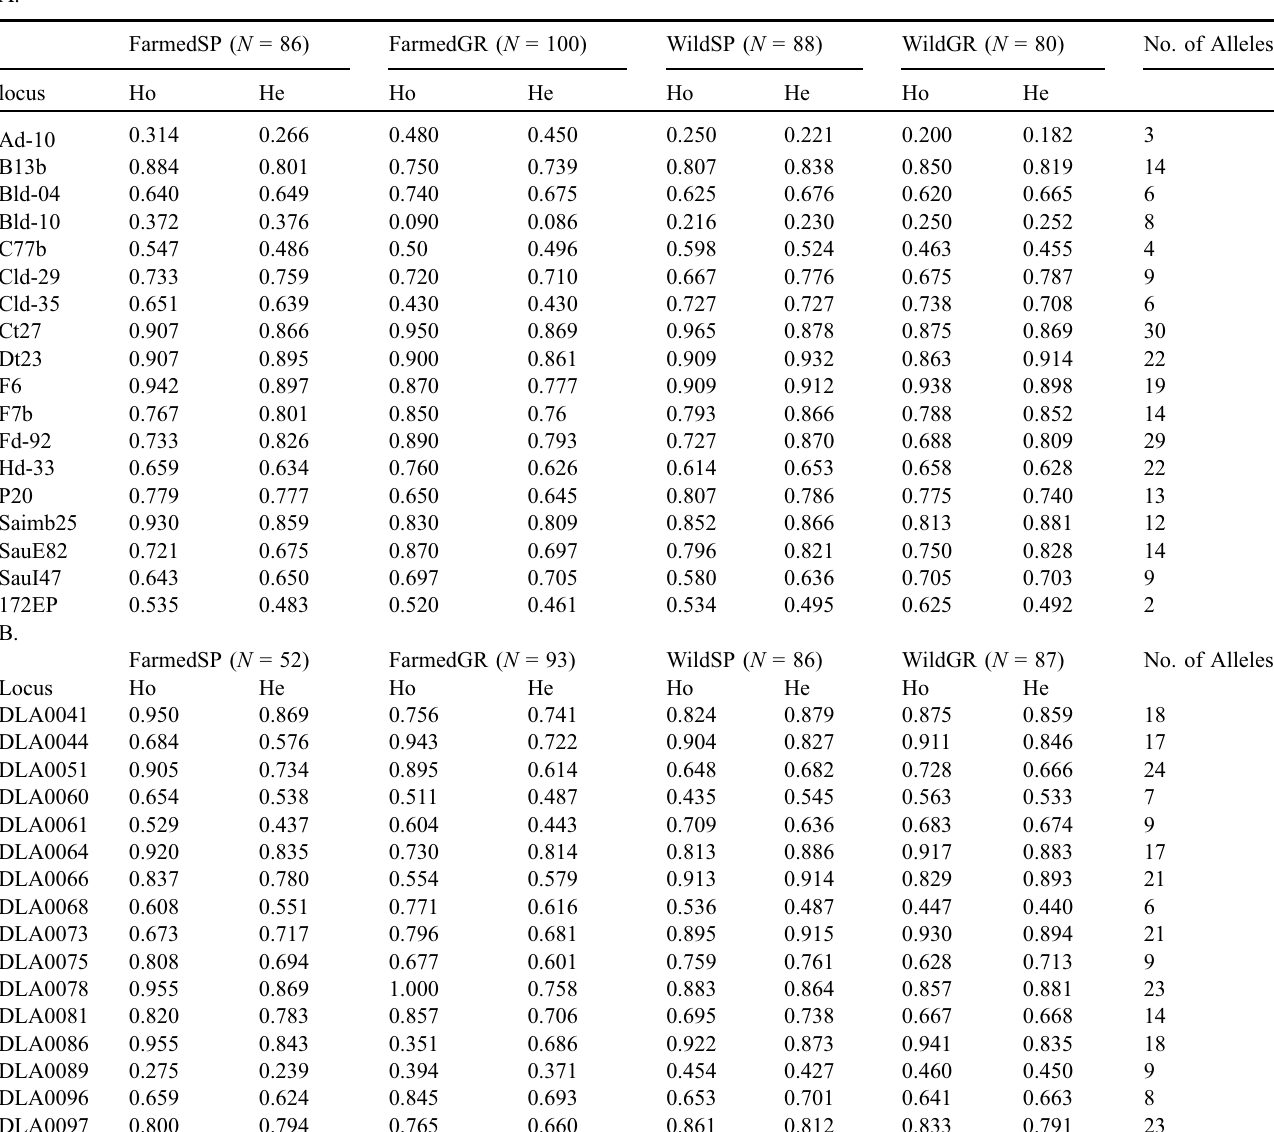
Table 1. Observed and expected heterozygosity for S. aurata (A) and D. labrax (B).